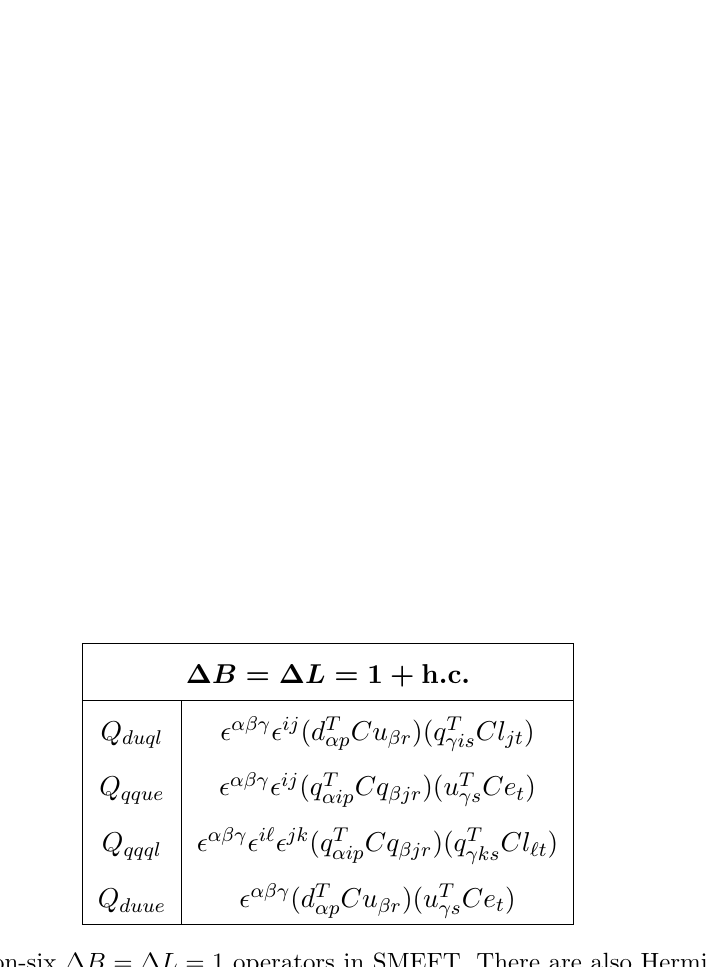
Table 6 . Dimension-six ∆ B = ∆ L = 1 operators in SMEFT. There are also Hermitian conjugate ∆ B = ∆ L = 1 operators, as indicated by + h . c . in the table heading. Subscripts p , r , s and t are − weak-eigenstate